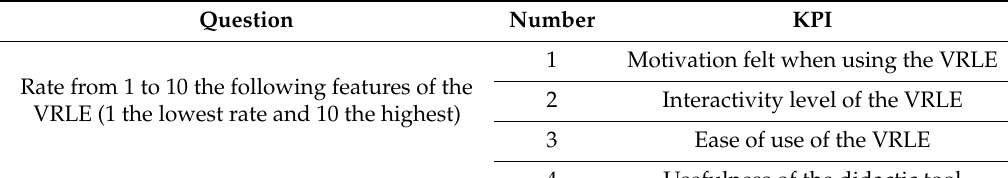
Table 1. Questions (related to this article) designed on surveys for students.